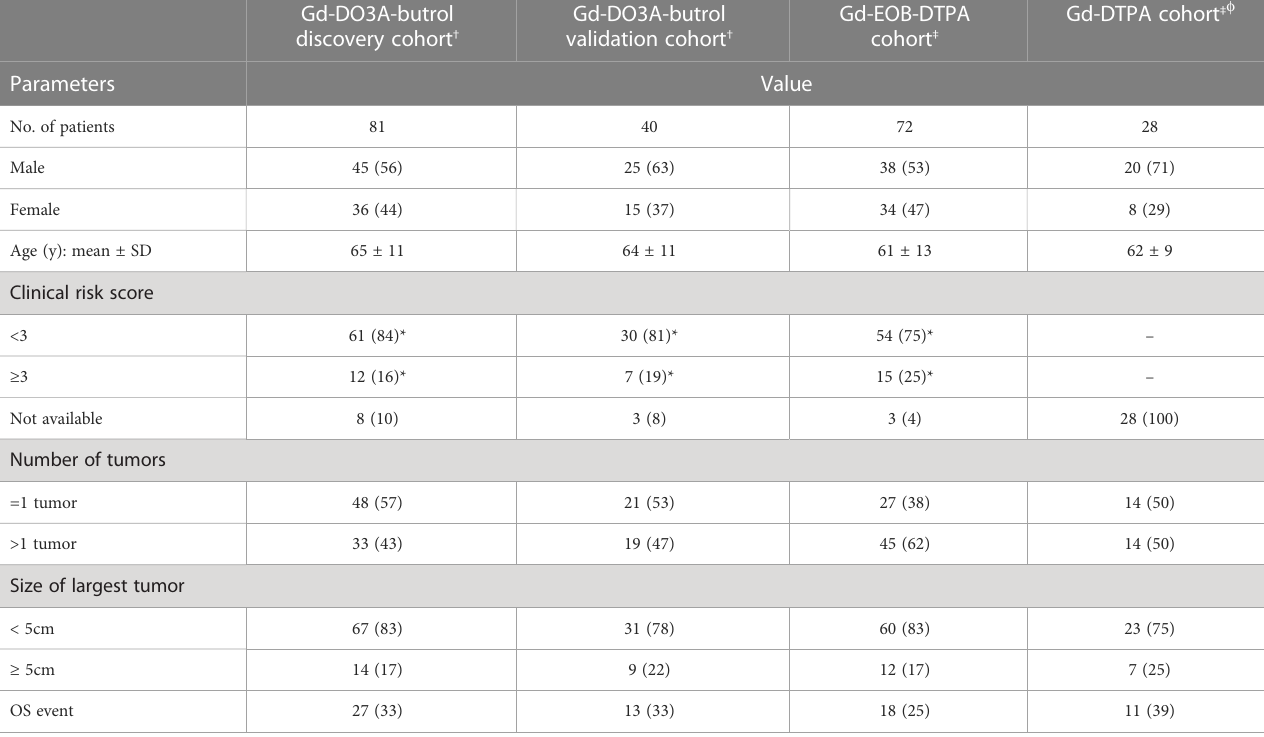
TABLE 1 Demographics of the study population (n =